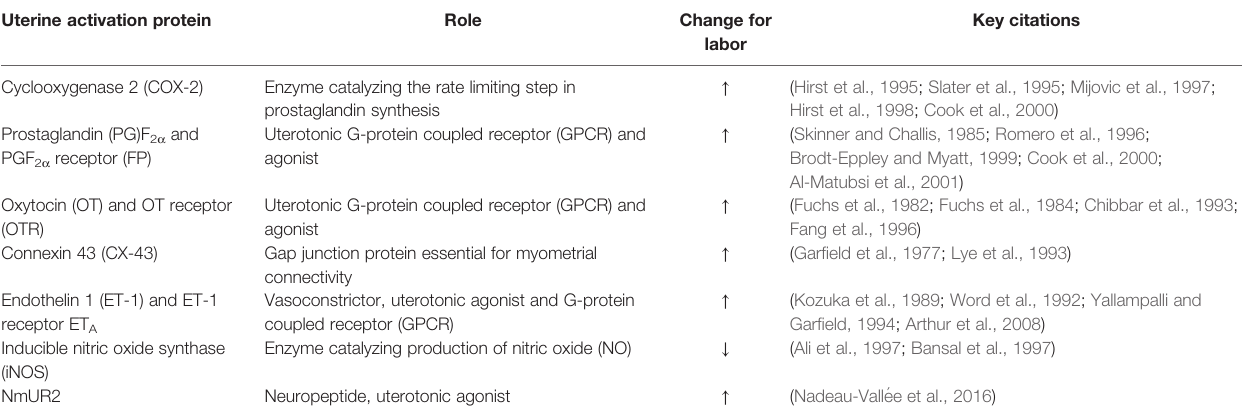
TABLE 1 | Uterine activation proteins change their expression for